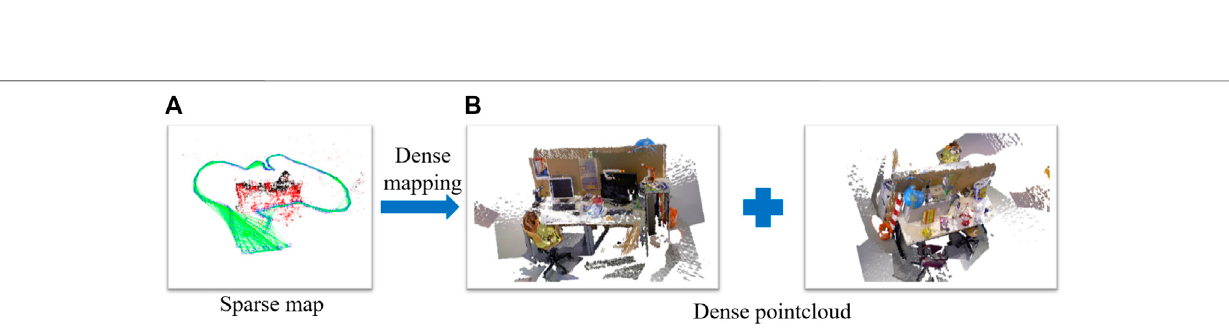
FIGURE 12 | The illustration of presented algorithm for dense point cloud map construction performance in the dynamic dataset, (A) is the sparse map, (B) is the dense point cloud map construction result.